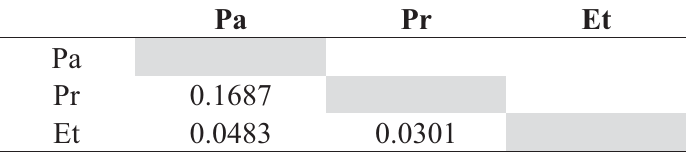
Table 5. Results from Fisher’s exact test of neutrality for pairs of percid CENP-A sequences (Pa: P. austroperka , Pr: P. roanoka , and Et: E. tallapoosae ). The probability (p) of rejecting the null hypothesis of strict-neutrality in favor of the alternative hypothesis of positive selection at the middle portion of the N-terminal tail (Figure 4, red underlined sequences) is shown for each pair. Values of p < 0.05 are considered